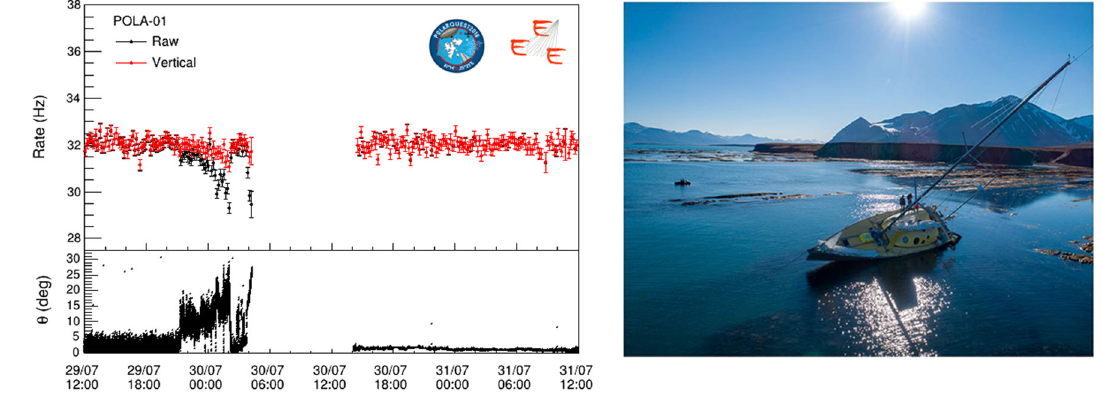
Fig. 20 Left: Raw rate measured by POLA-01 (black points in the upper plot) from July 29 to July 31, 2018, when the boat was inclined foraperiodofabout9h.Alsotheratecorrectedfortheinclinationeffect (red points) and the inclination angle (black points in the lower plot) are shown. In this case, a 10 min binning has been used for the rate, while